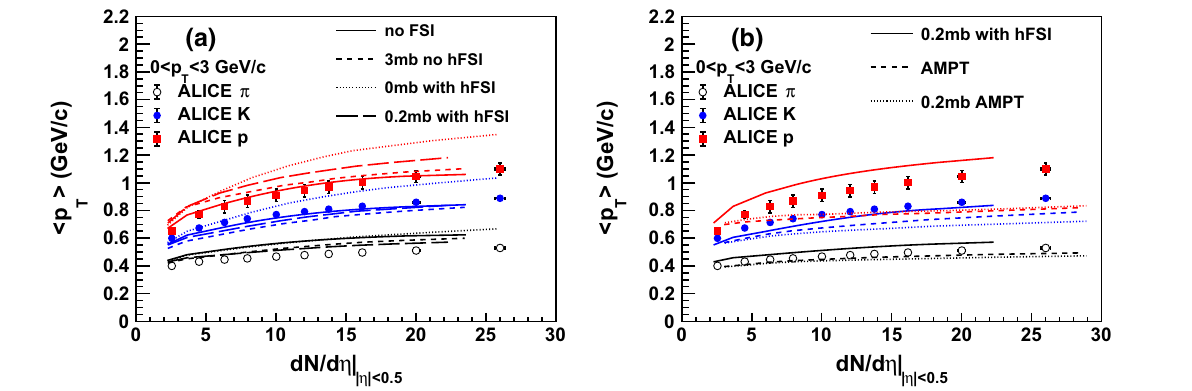
Fig. 9 Average transverse momentum of π (black), K (blue) and pro- ton (red) at mid-rapidity with 0 < p T < 3 GeV / c versus the charged hadron multiplicity density. Final state effects are shown in ( a ). Com-